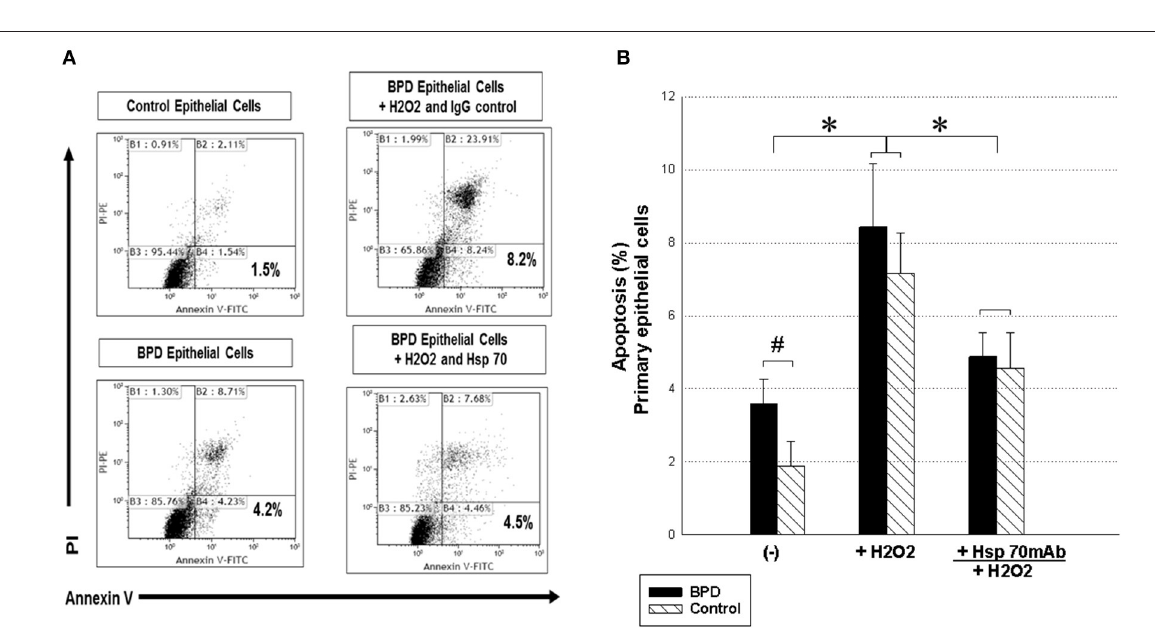
FIGURE 4 | Recombinant human Hsp-70 decreases H 2 O 2 -induced airway epithelial cell apoptosis from TA in the controls and patients with BPD. (A) To detect the role of Hsp-70 in early apoptotic cells with annexin-V-positive but PI-negative respiratory epithelial cells from TA after exposure to hydrogen peroxide, a FITC annexin-V/propidium iodide Apoptosis Detection Kit I (BD Pharmingen, USA) was used. Recombinant human Hsp-70 (5 µ g/ml) was incubated with primary epithelial cells (1 × 10 5 cells) from the TA of patients with BPD and of control subjects and then cultured with H 2 O 2 (0.5mM) for 1h followed by 8h of recovery.